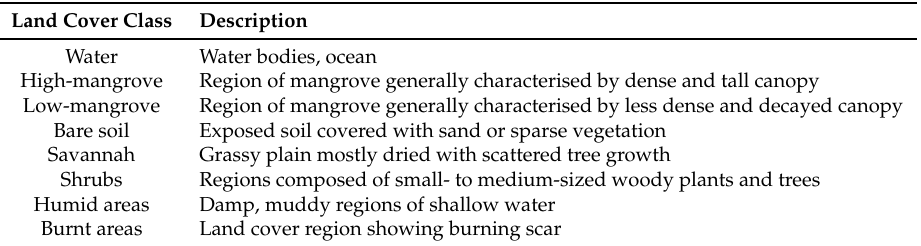
Table 1. Land cover classes composing the study area and their